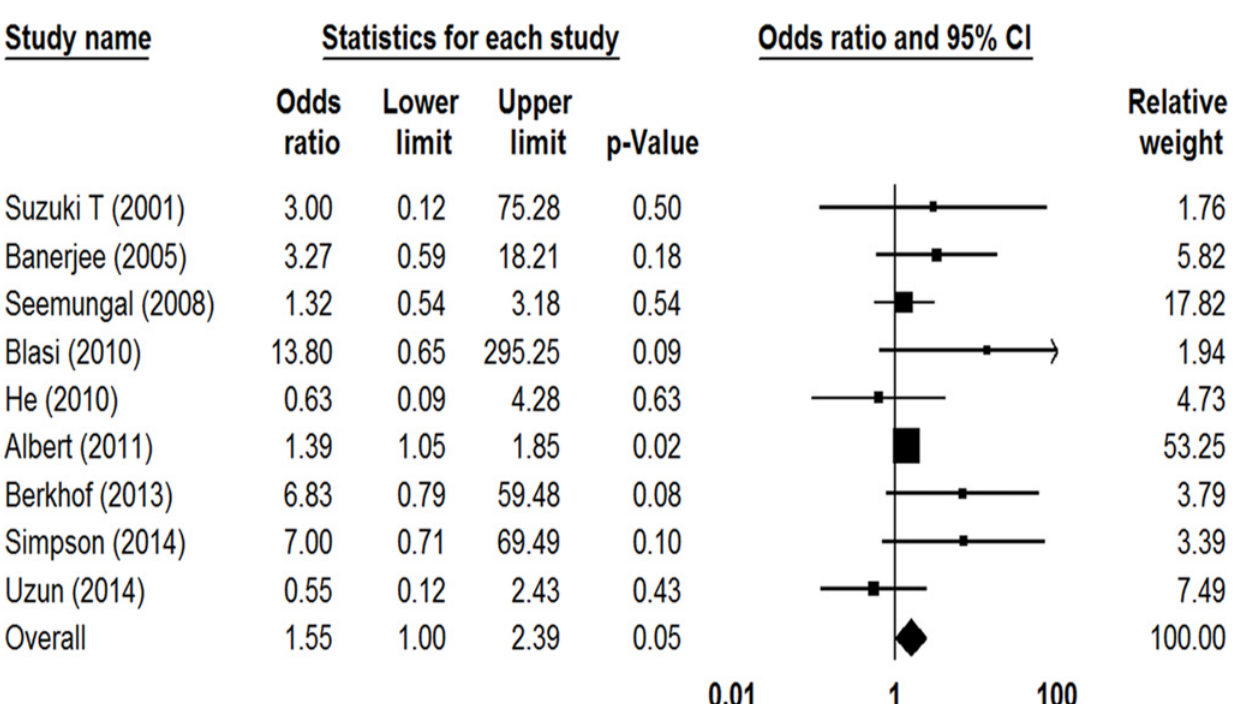
Fig 6. Forest plot of odds ratios for drug adverse effects in COPD patients treated with macrolides compared with the control.